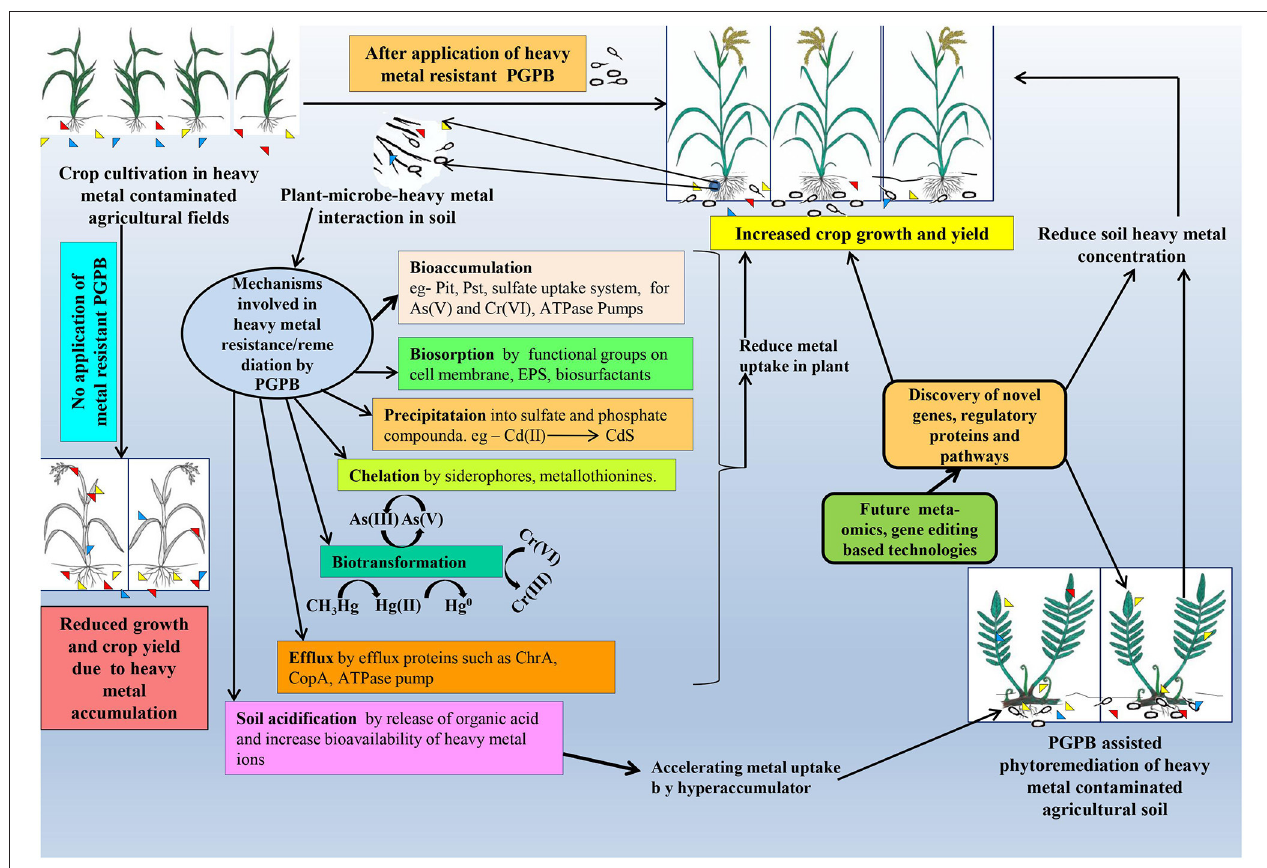
FIGURE 1 | Thematic representation of microbe-assisted heavy metal remediation and its consequence on plant systems.